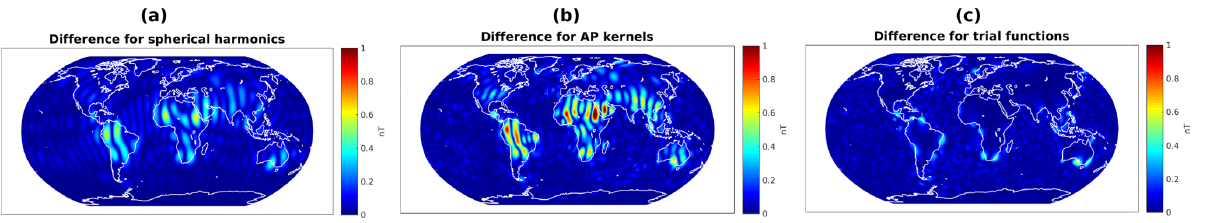
Figure 10. The difference between the approximations B N of the undisturbed B X3DG oc (as shown in Fig. 7a, b, and c) and the approximations e e B N of the noisy B oc (as shown in Fig. 9a, b, and